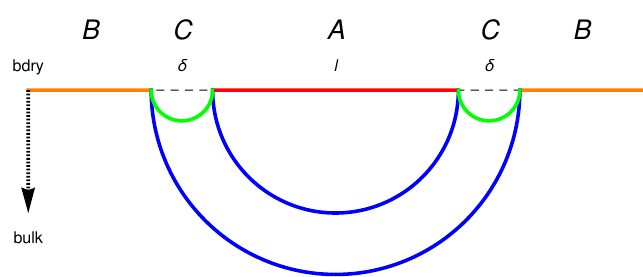
Figure 8 . Strip con(cid:12)guration we consider in the de(cid:12)nition of the c-function. We have a strip of width l bordered by two thin strips of width (cid:14) . We consider the mutual information between the center strip (red) and the exterior